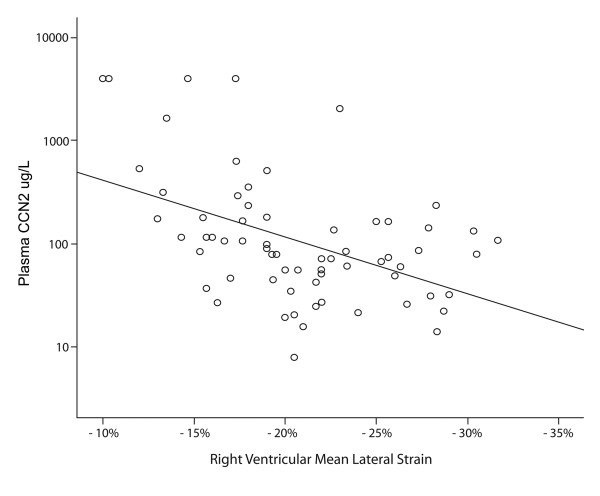
Linear relationship between plasma connective tissue growth factor and right ventricular strain. Scatter plot showing the inverse relationship between plasma connective tissue growth factor (CCN2) levels and right ventricular strain (linear regression, r = 0.47, p < 0.001). Due to the presence of extreme outliers, plasma CCN2 levels are plotted on the y-axis using a logarithmic (log10) scale.